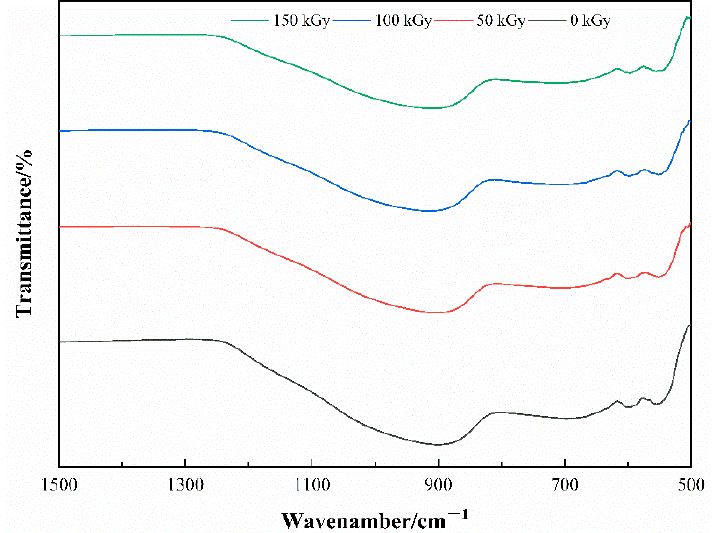
Figure 6. Fiber ‐ 1 FTIR characteristics before and after the irradiation.